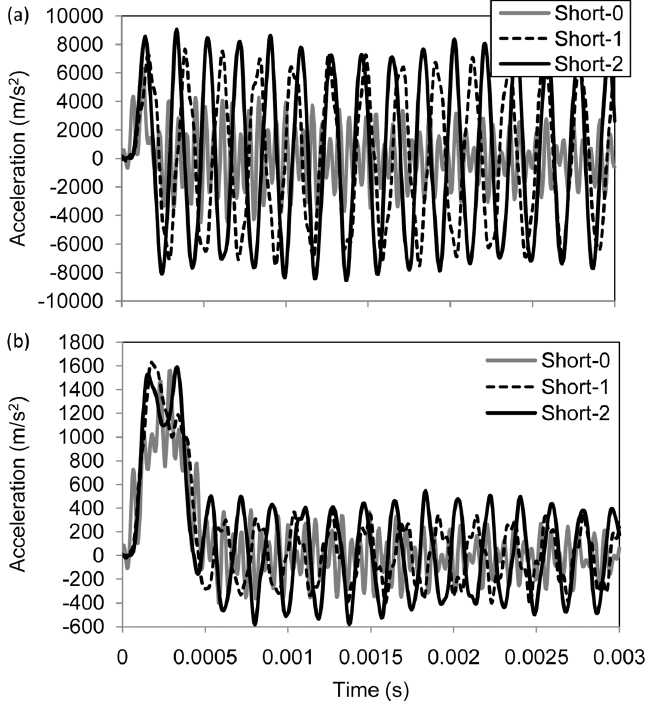
Fig. 11. Computational results of acceleration responses of short structures under impact loading using (a) hard and (b) medium tip impacts. 20,000 Hz cutoff frequency is used for low-pass fi